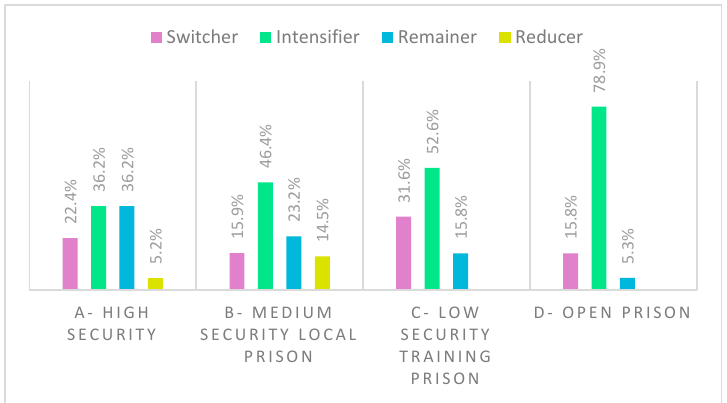
Figure 7. Type of religious change by security category.